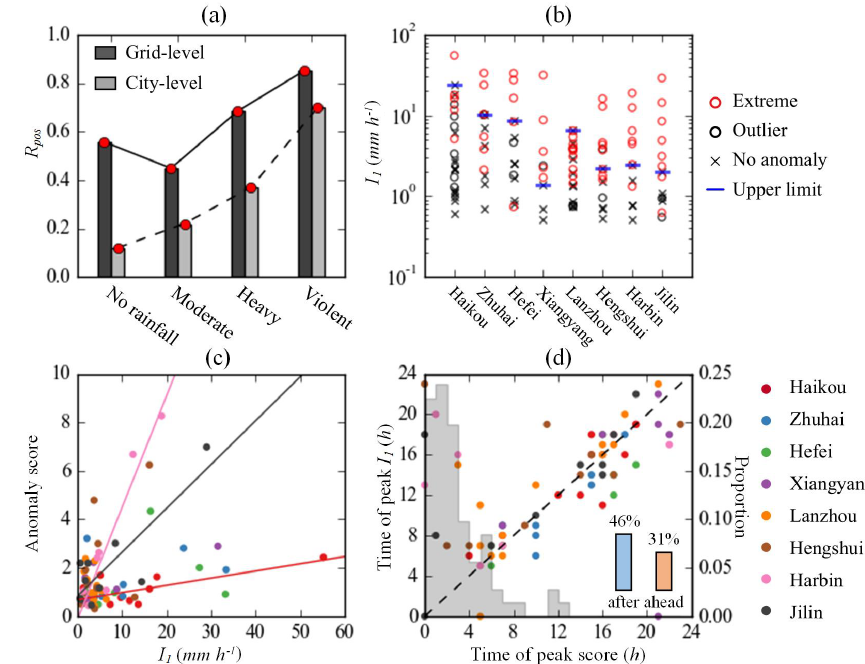
Figure 7. Correlation between peak rainfall intensity and the anomaly